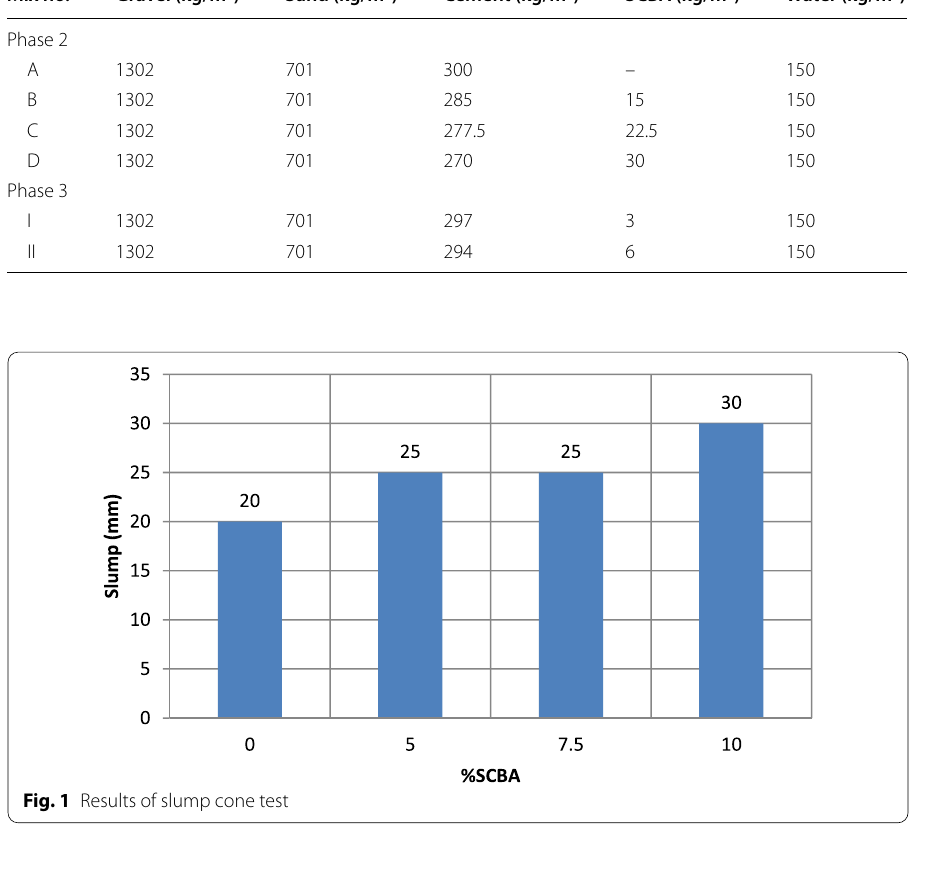
Table 3 Mixing proportions of all specimens Mix no.